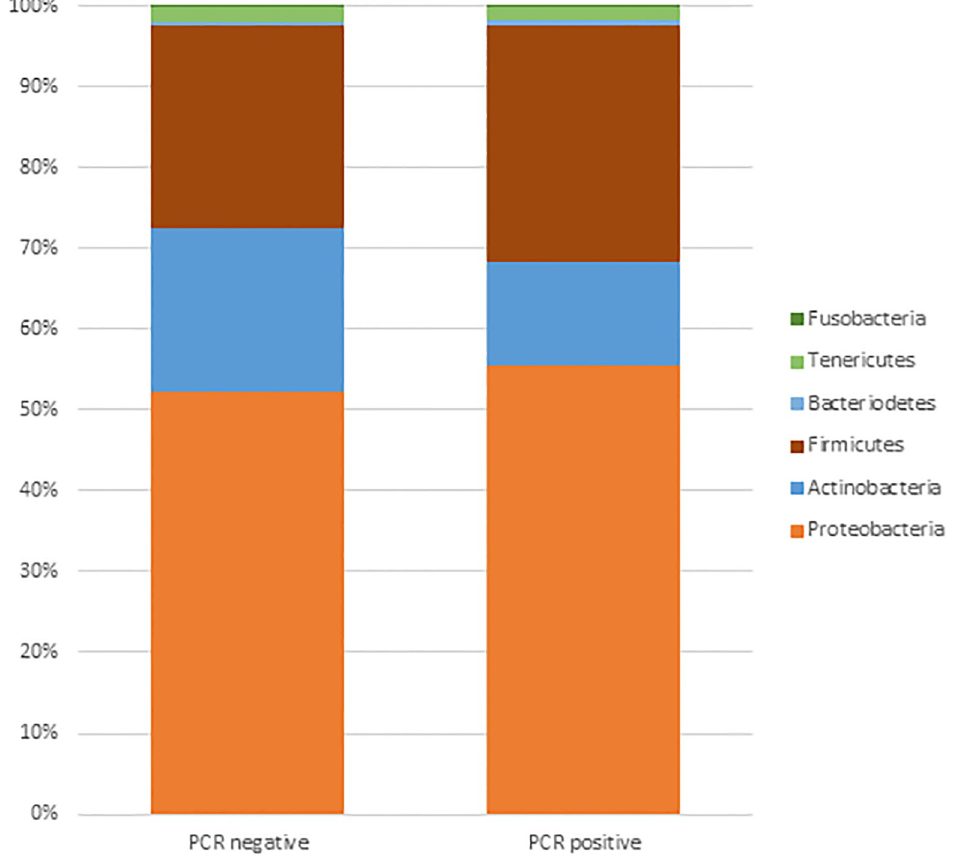
Fig 6. Proportion of normalized bacterial reads per phylum.